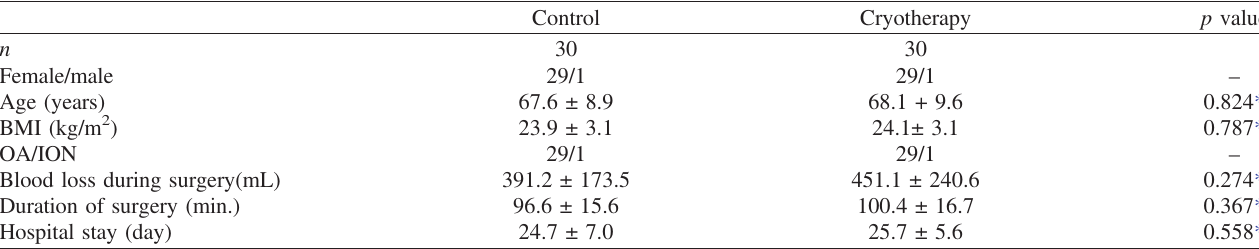
Table 1. Demographic data of patients in two